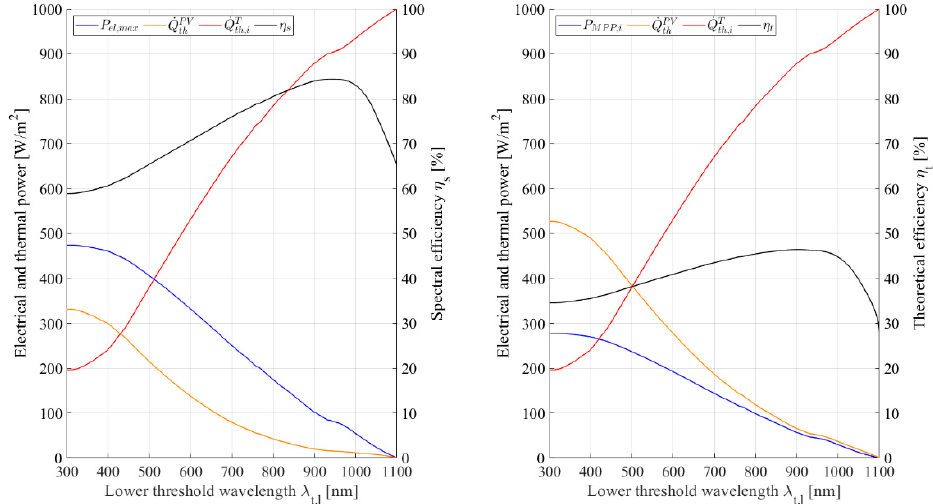
Figure 5. Key parameters of Spectral Splitting depending on lower threshold wavelength, considering spectral efficiency ( left ) and theoretical efficiency ( right ), for c-Si PV technology.